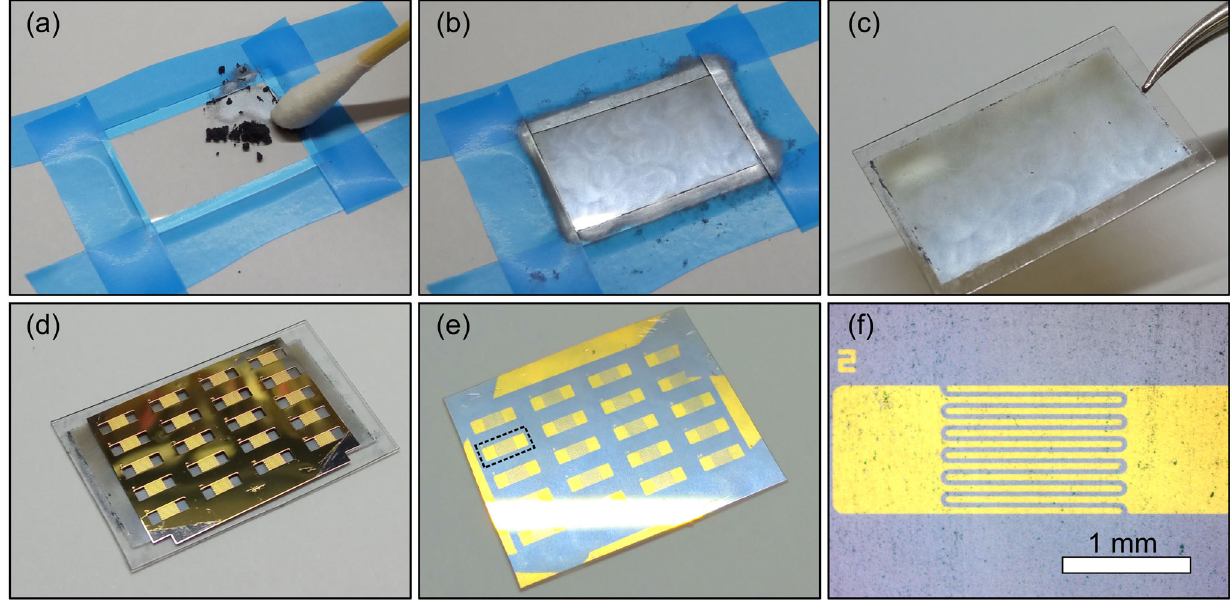
Fig. 1 Fabrication steps of the fl exible large-area WS 2 photodetectors. a Fine WS 2 powder is rubbed against the surface of a polycarbonate substrate with a cotton swab. b , c Pictures of the WS 2 fi lm on polycarbonate after deposition. d A shadow mask is placed onto the surface of the fi lm. e Picture of a polycarbonate chip after the evaporation of 20 devices. f Higher magni fi cation image of one of the devices, highlighted with a dashed rectangle in e .